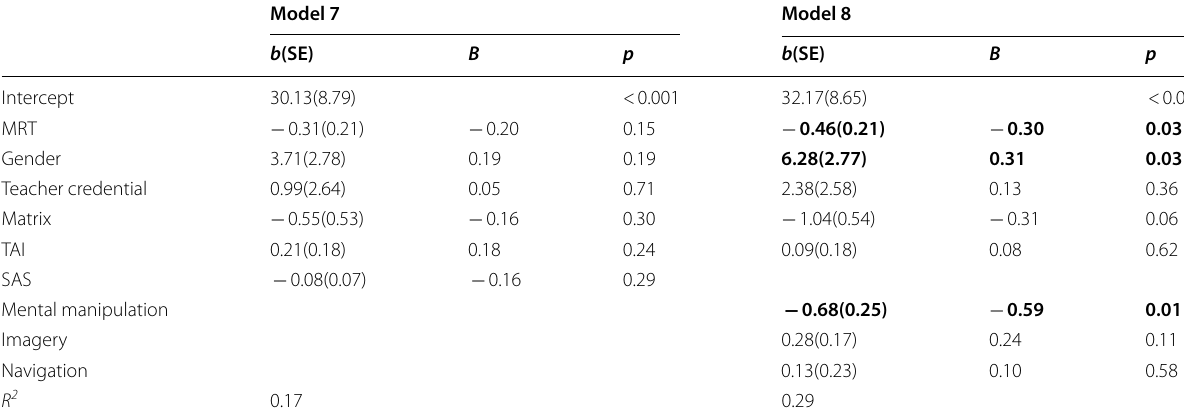
Table 9 Regression analyses examining if teachers’ spatial skills and spatial anxiety predict their use of spatial pedagogical practices during remote instruction